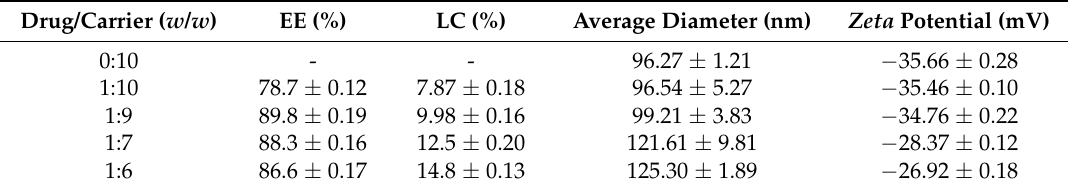
Table 2. Characterization of DTX-SA-BSPs copolymer